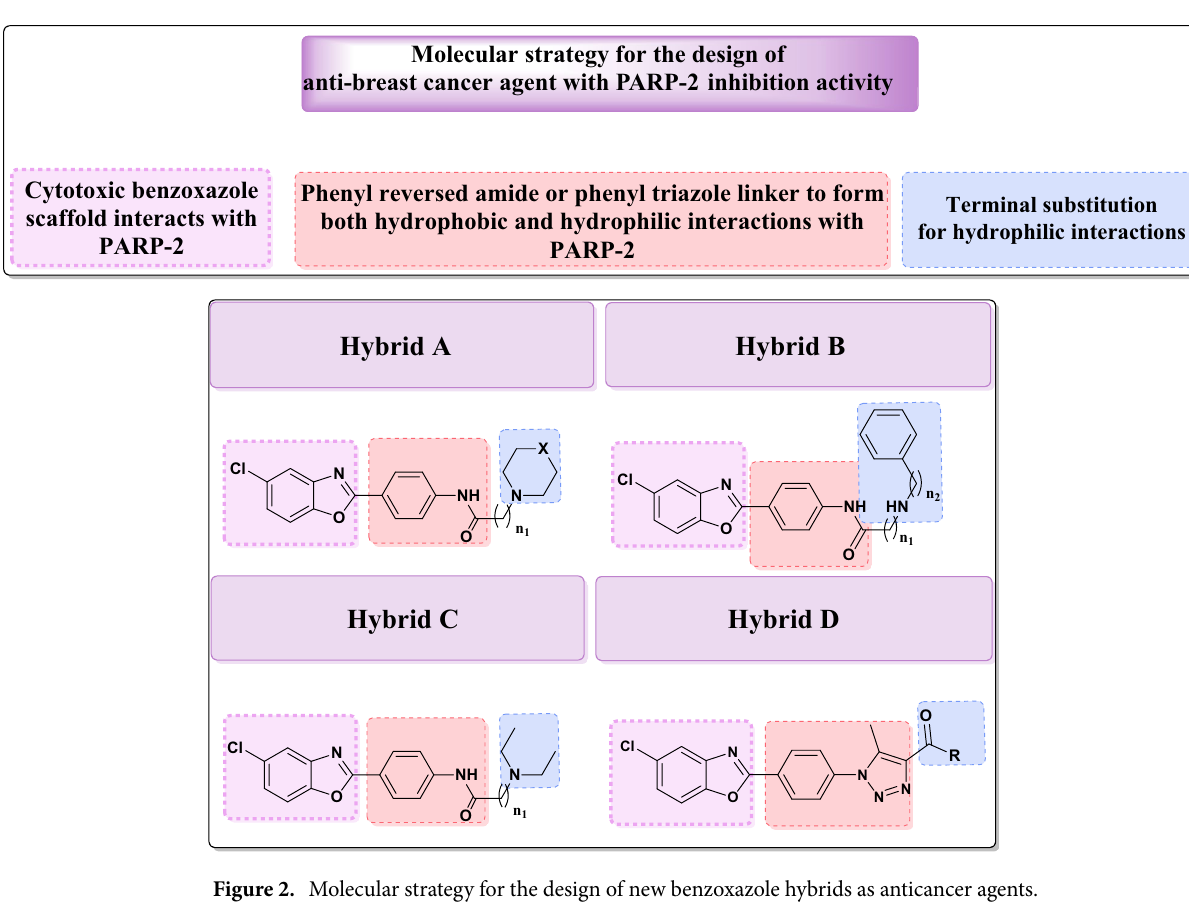
Figure 2. Molecular strategy for the design of new benzoxazole hybrids as anticancer agents.